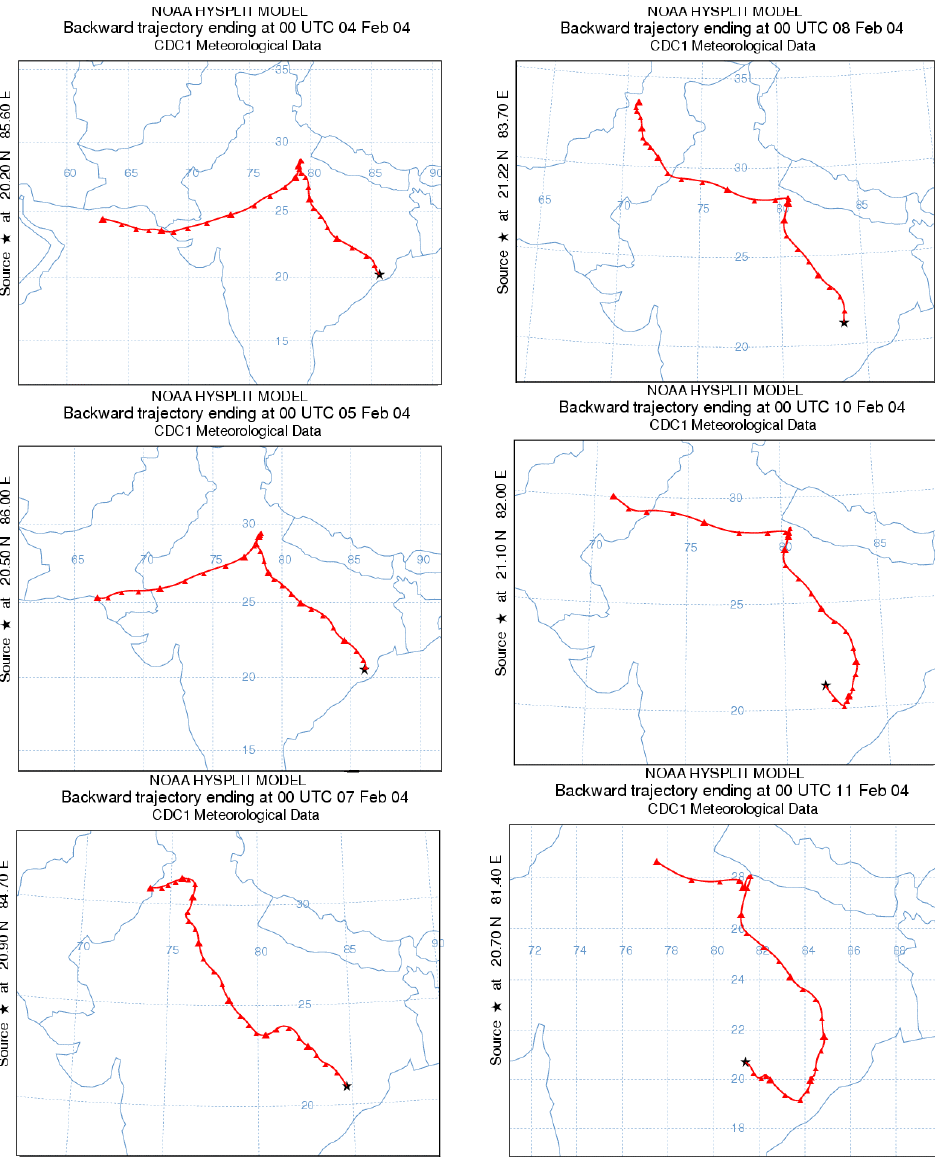
Fig. 11 Fig. 11. Same as Fig. 10 for northern observation